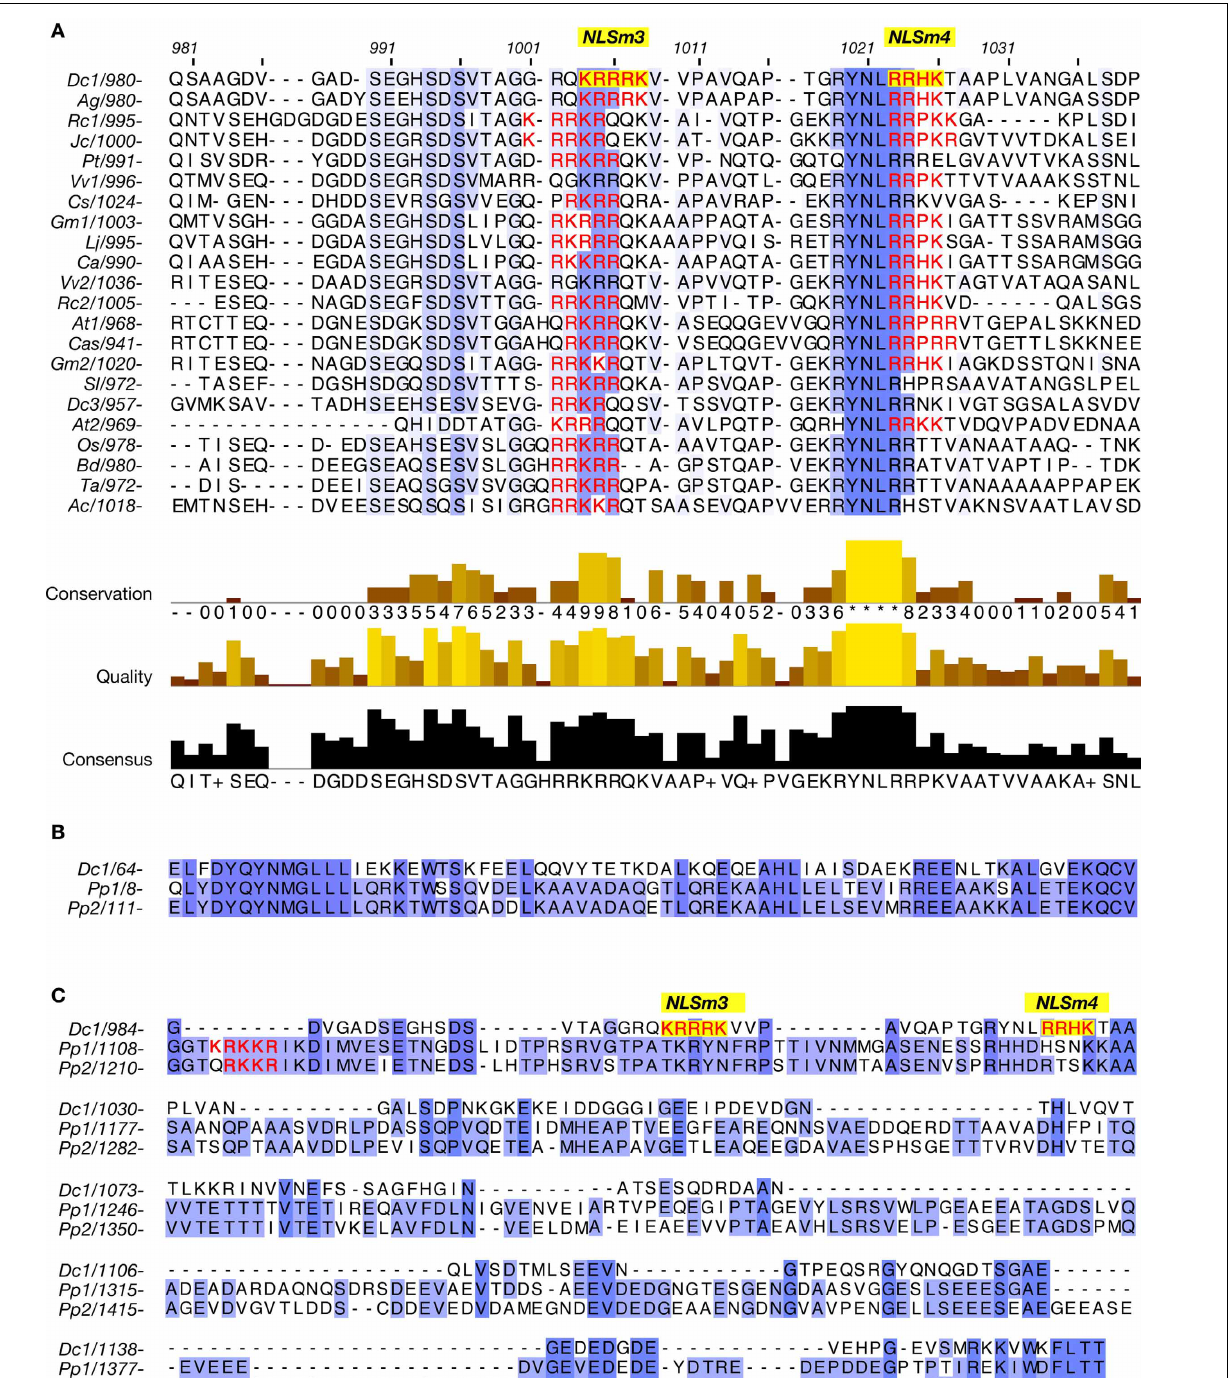
FIGURE 5 | A region required for localization to the nuclear periphery includes the conserved amino acid sequence R/Q/HYNLRR/H. (A) Alignment of a region including functional NLSs of DcNMCP1 and the corresponding sequence of homologous proteins from other plants. (B,C) Alignment of regions from DcNMCP1 and NMCP1-like proteins deduced from Physcomitrella patens hypothetical genes. These homologues include the consensus MGLLL and a carboxy-terminal amino acid sequences but lack the sequence motif R/Q/HYNLRR/H. NLS motifs are indicated by red characters (NLSm3 and NLSm4 are indicated by yellow boxes). Plant